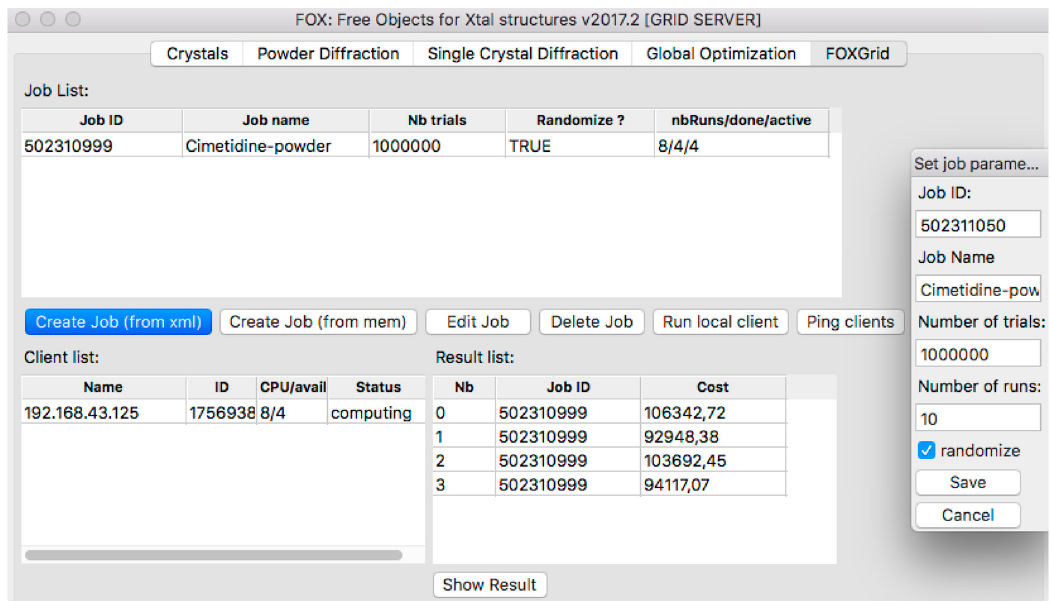
Figure 2 . FOXGrid server interface, giving access to distributed computing options. In this example, a single job has been loaded, with 4 runs done out of 8. Each run starts from a randomized structure, for one million trials. In this case, only the local computer is used, with 4 computing units to exploit the 4 cores of the computer. The results already obtained are listed at the bottom right (and, in this case, are all correct solutions), and can be individually displayed. The inset widget on the right shows the simple interface for creating a new job.